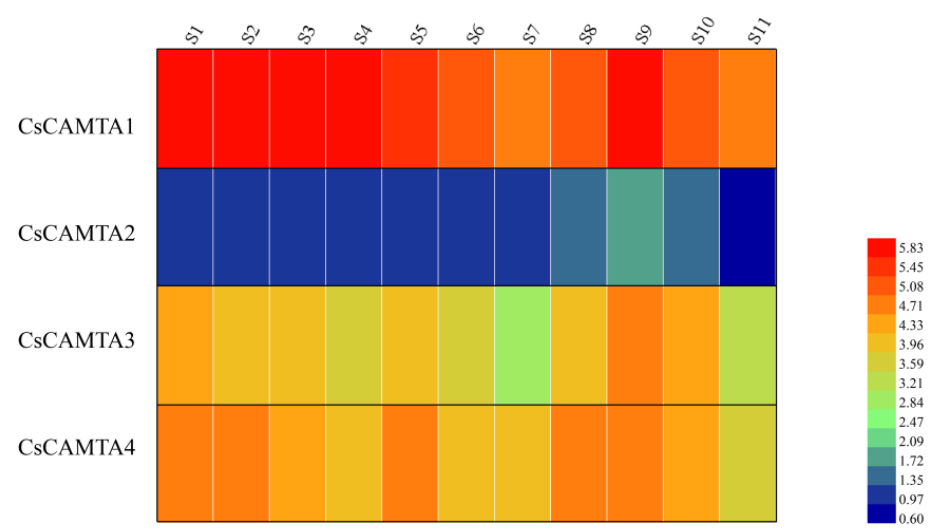
Figure 5. Tissue-specific expression analysis of CsCAMTAs . RNA-seq data were obtained from NCBI (accession number: SRP071224). S1, roots of 4-week-old seedlings; S2, stem of 4-week-old seedlings; S3, cotyledon of 4-week-old seedlings; S4, true leaf of 4-week-old seedlings; S5, root; S6, stem; S7, young leaf; S8, old leaf; S9, female flower; S10, male flower; S11, flesh of 1-week-old fruit. Red and blue indicate high and low levels of expression level, respectively. The color bar represents the expression values.